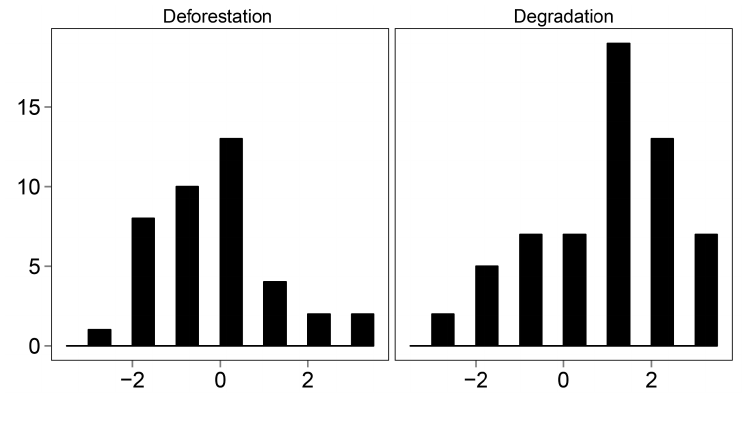
Figure 6. Histogram of time lags in capturing deforestation ( left ) and forest degradation by remote sensing (SPOT and RapidEye) imagery ( right ); a time lag is defined as the difference between change dates observed from remote sensing image interpretation and those dates recorded by local